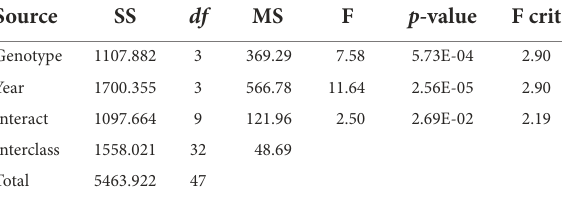
TABLE 1 Two-way ANOVA of DSI among different genotypes and